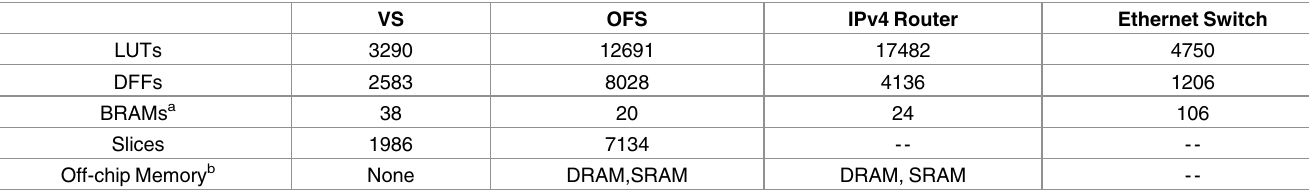
Table 2. Resource statistics for severalkinds of switch hardware based on the NetFPGA. VS OFS IPv4 Router Ethernet Switch LUTs 3290 12691 17482 4750